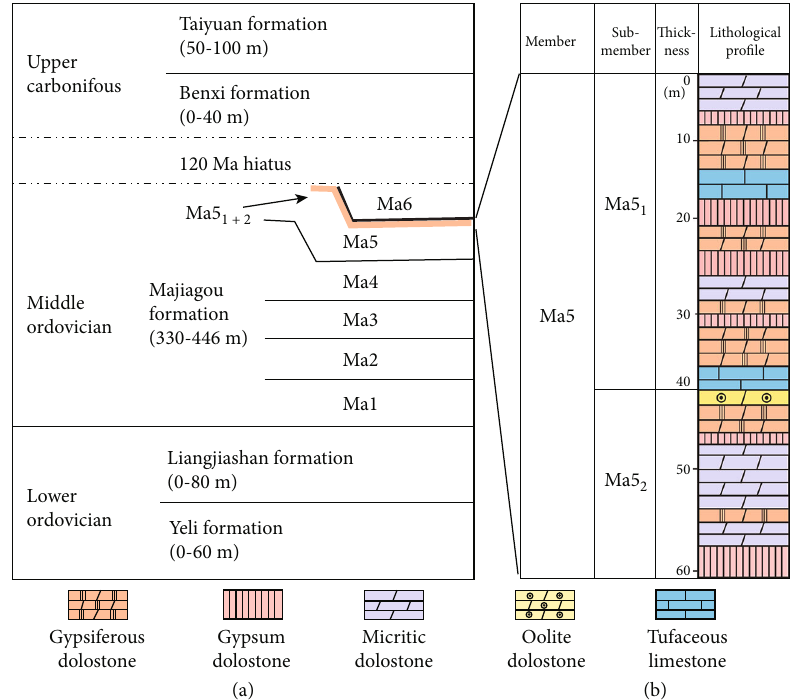
Figure 2: Stratigraphic development map of the Gaoqiao gas fi eld. The studied Majiagou Formation (Ma) 5th Member (Ma5) is highlighted (Figure 2(b)).